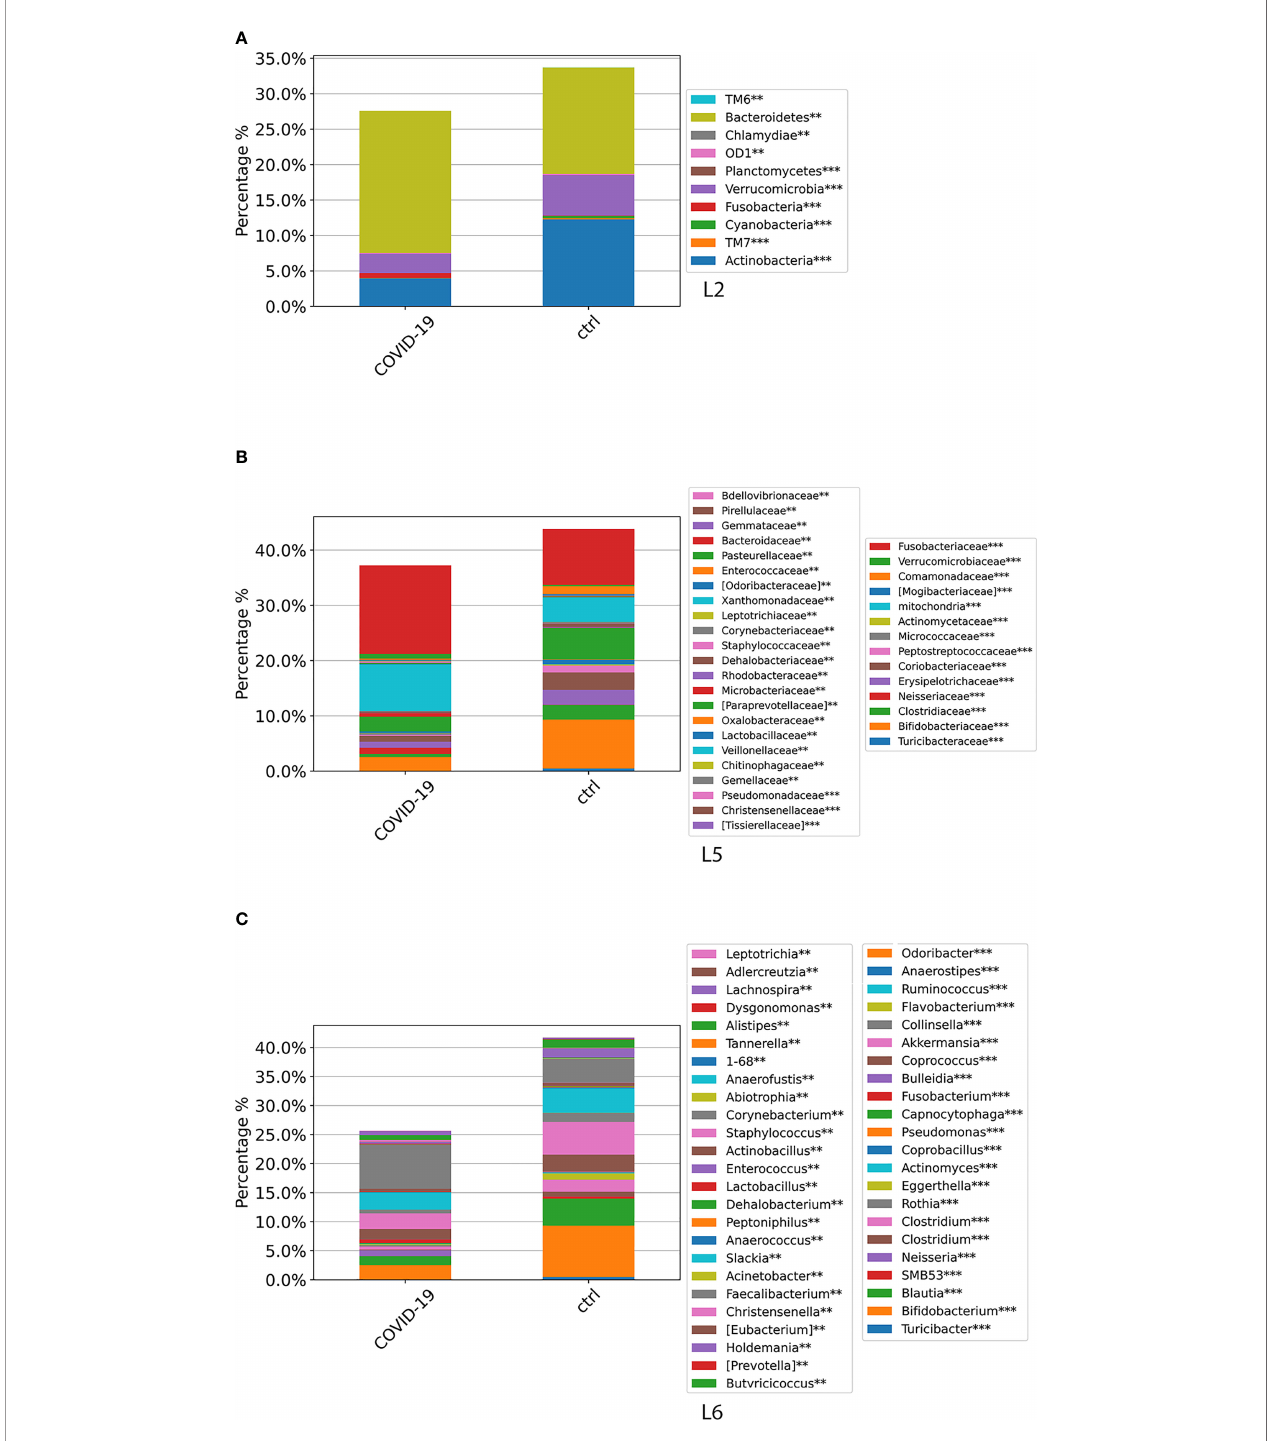
FIGURE 4 | ASV distributions at L2 (A) , L5 (B) , and L6 (C) , fi ltered by statistically signi fi cance based on the Kruskal – Wallis test. * p -value < 0.001; p -value **FDR < 0.05; *** p -value FDR < 0.001. ASV distributions were reported in the comparisons among COVID-19 and CTRL